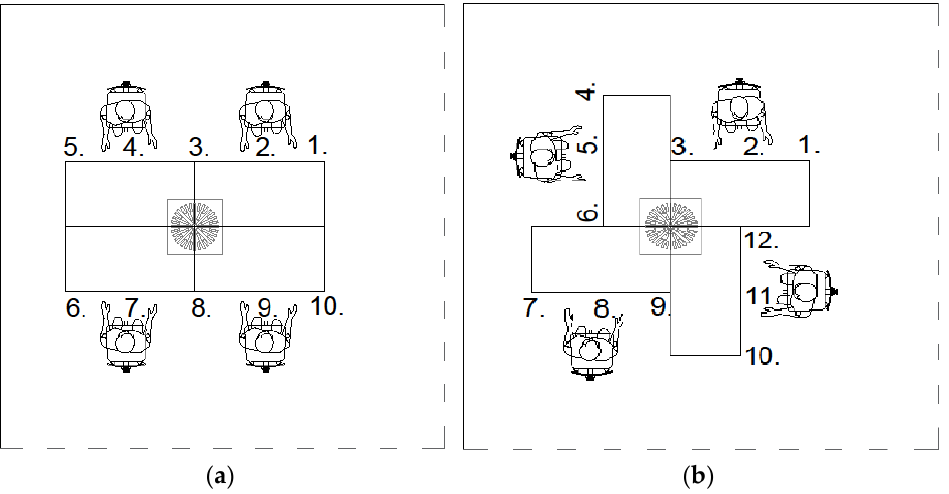
Figure 2. Workstation set-ups ( a ) island of four and measurement points (1–10), ( b ) flower and measurement points (1–12).